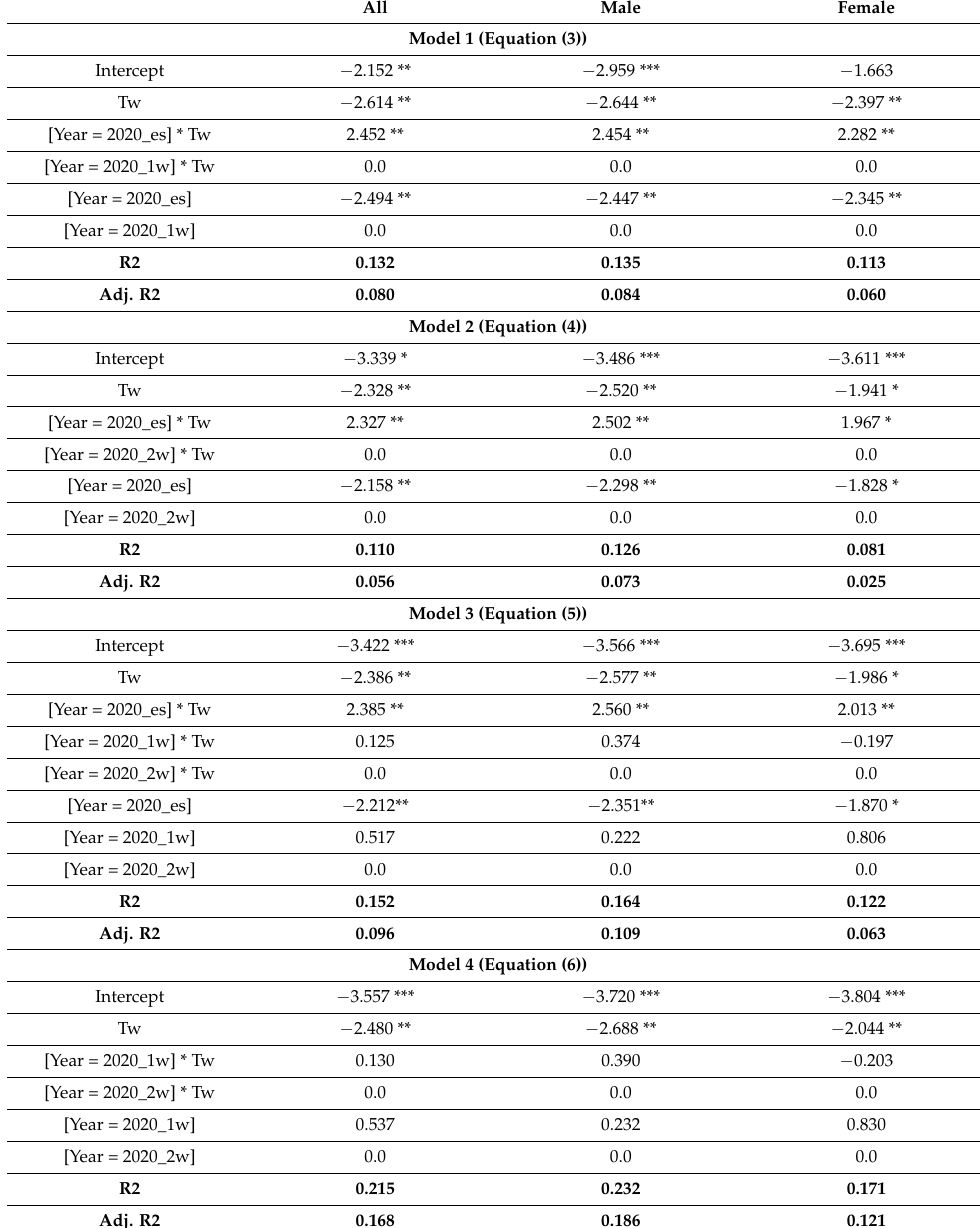
Table 6. Parameter estimates associated with GDP for